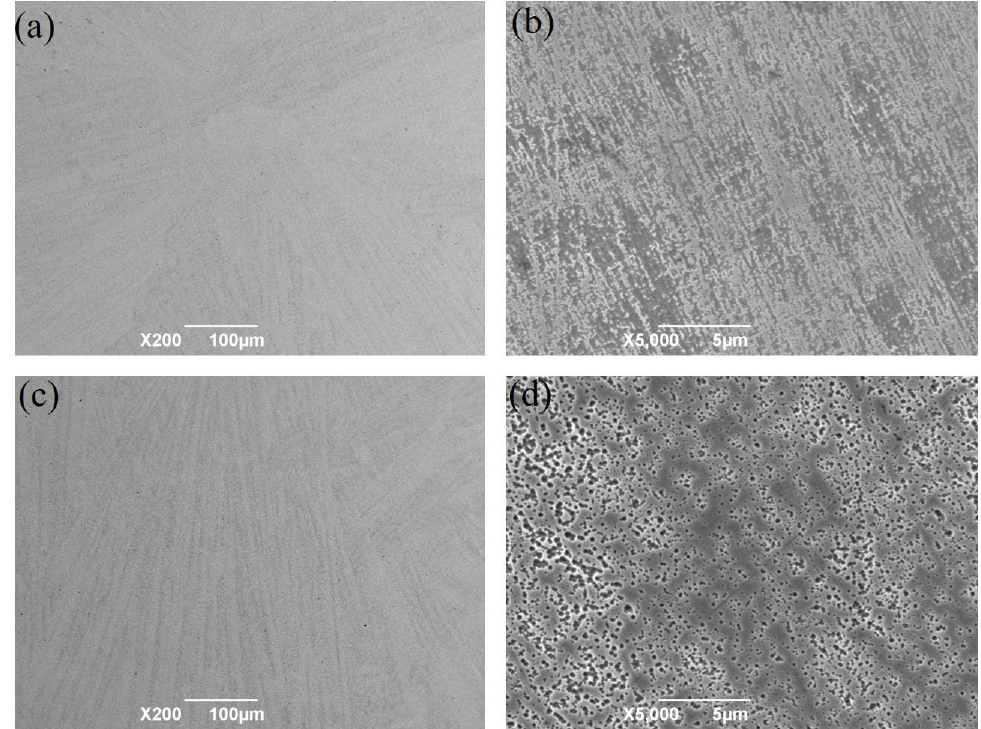
Figure 8. The SEM images of as cast ( a , b ) and heat treated (HT) ( c , d ) Al 0.25 CoCrFeNi high-entropy alloy. The heat treatment procedure is firstly heated to 650 °C at the heating rate of 10 K/min, holding for 1 min and quenched in water.